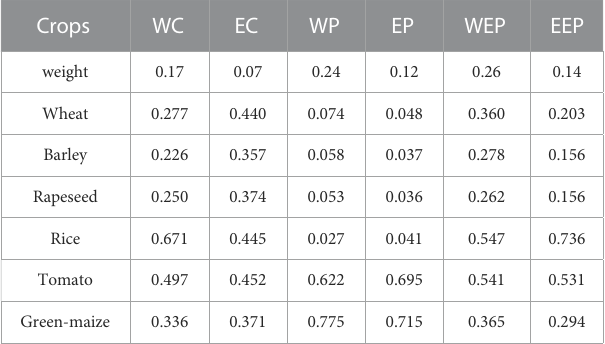
TABLE 3 The normalized performance matrix of TOPSIS method.